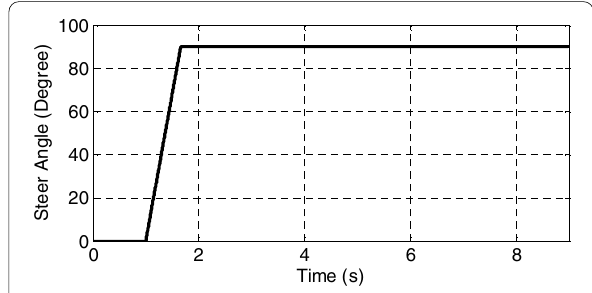
Figure 10 Steer angle of Condition 4